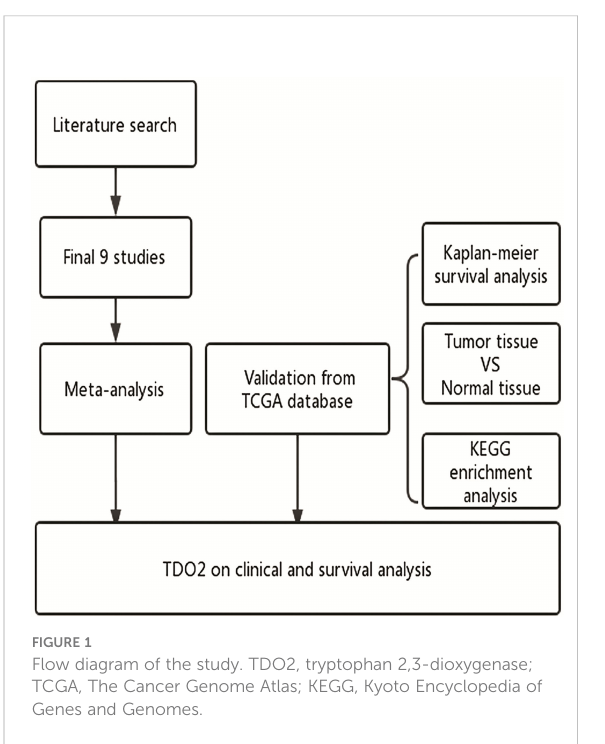
FIGURE 1 Flow diagram of the study. TDO2, tryptophan 2,3-dioxygenase; TCGA, The Cancer Genome Atlas; KEGG, Kyoto Encyclopedia of Genes and Genomes.